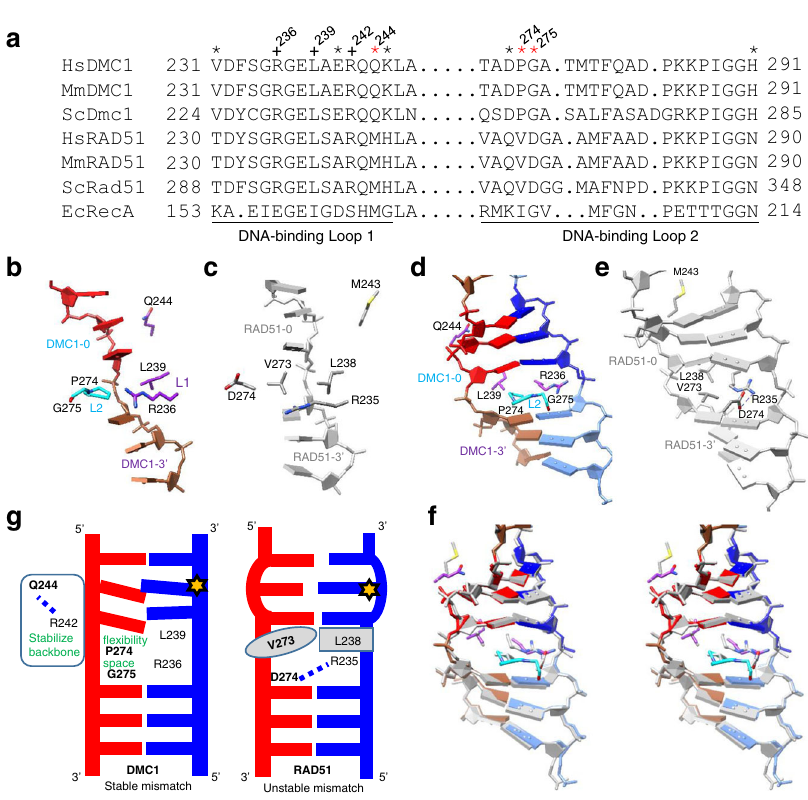
Fig. 1 Possible fi delity-controlling residues of DMC1 and RAD51. a Alignment of the amino acid residues in the Loop 1 and Loop 2 of DNA recombinases from H. sapiens (Hs), M. musculus (Mm), S. cerevisiae (Sc), and E. coli (Ec). All asterisks denote Loop 1 and Loop 2 lineage-speci fi c amino acids, whereas red asterisks denote the three key residues identi fi ed in this study. Three conserved residues also addressed in this study are indicated by a + sign. b , c Inter- triplet area of DMC1 and RAD51 (PDB 5H1B 28 ) in the presynaptic fi lament. d , e The same as b , c , except for the postsynaptic fi laments of DMC1 and RAD51 (PDB 5H1C 28 ). f Stereo view of the superposed d and e . The conserved residues DMC1 R236 and L239 from Loop 1, and the lineage-speci fi c residues DMC1 P274 and G275 from Loop 2 are shown in sticks. The labels of DMC1 protomers are based on the designation of RAD51 protomers interacting with a nucleotide triplet from 5 ′ to 3 ′ as RAD51-5 ′ , RAD51-0, and RAD51-3 ′ as described in Xu et al. 28 . g A schematic model showing the three lineage-speci fi c residues (bolded) coordinating with three conserved residues (non-bolded) to contribute to the mismatch tolerance (low fi delity) of DMC1 and the unstable mismatch (high fi delity) of